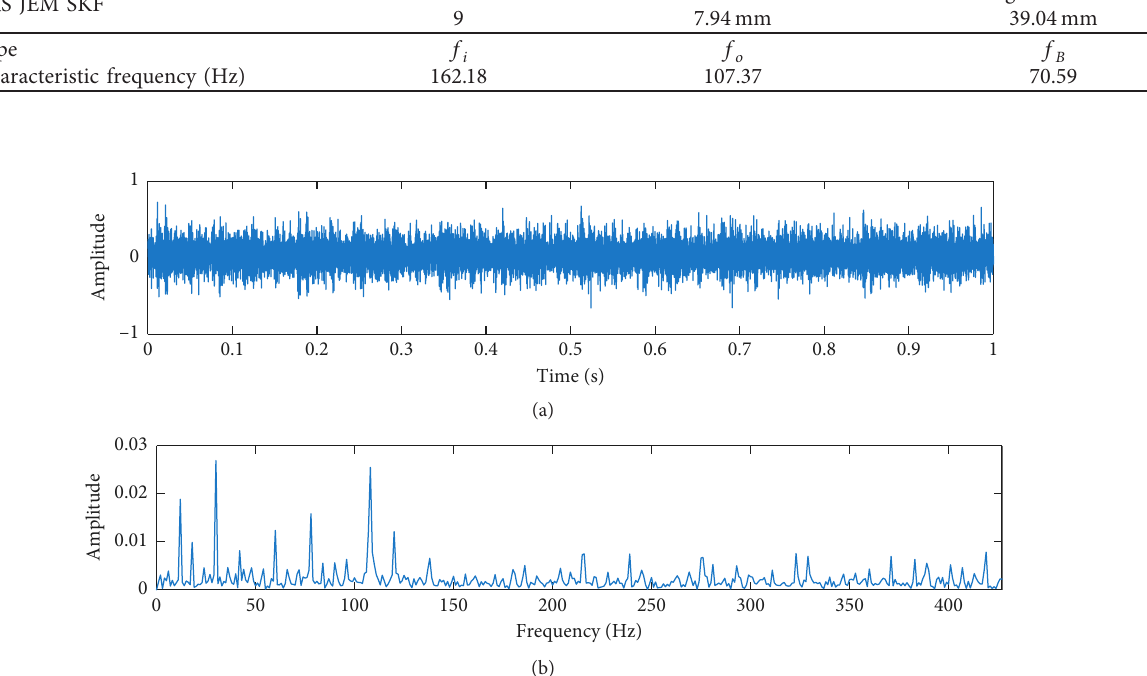
Figure 21: The experimental bearing vibration data of CWRU bearing data center: (a) waveform; (b) envelope